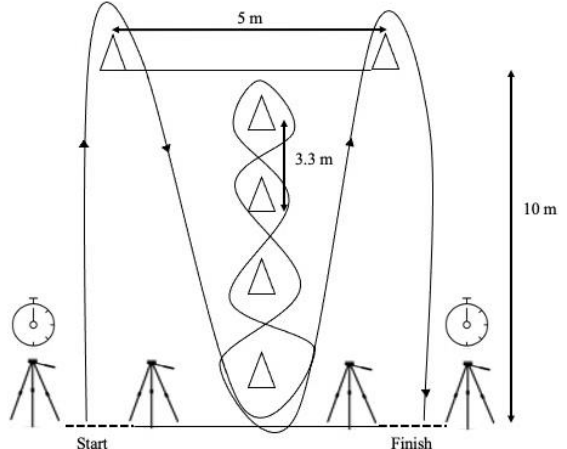
Figure 3. Illinois agility